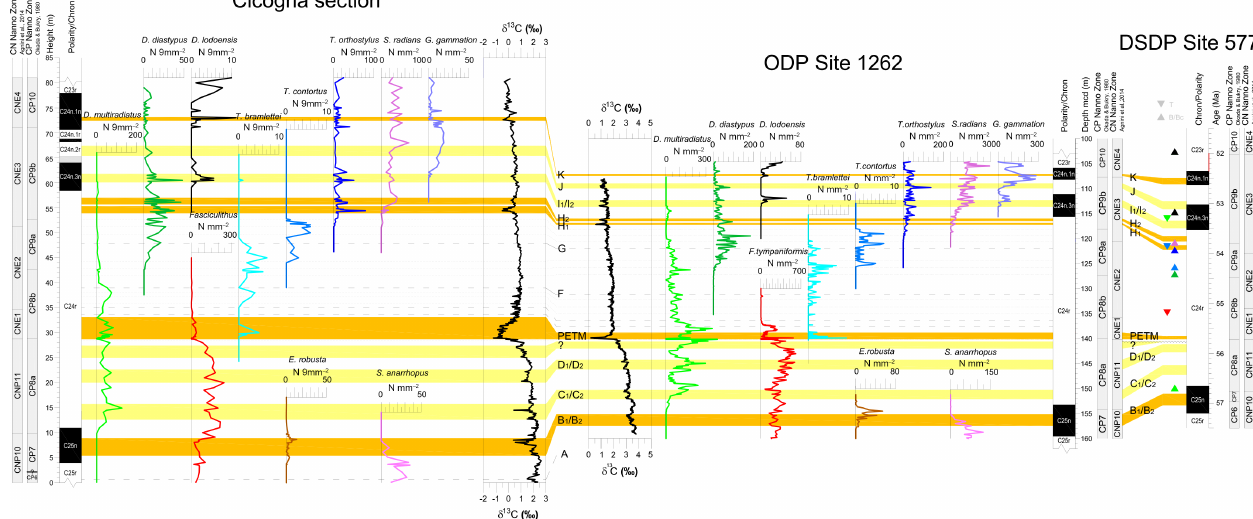
Figure 11. Comparison of δ 13 C profiles and semi-quantitative abundance patterns of selected calcareous nannofossil taxa from the Cicogna section and ODP Site 1262. Calcareous nannofossil biohorizons from DSDP Site 577 are reported in the right part of the figure. Orange and yellow bands mark CIEs shown in previous figures. Color bands and symbols are the same as in previous